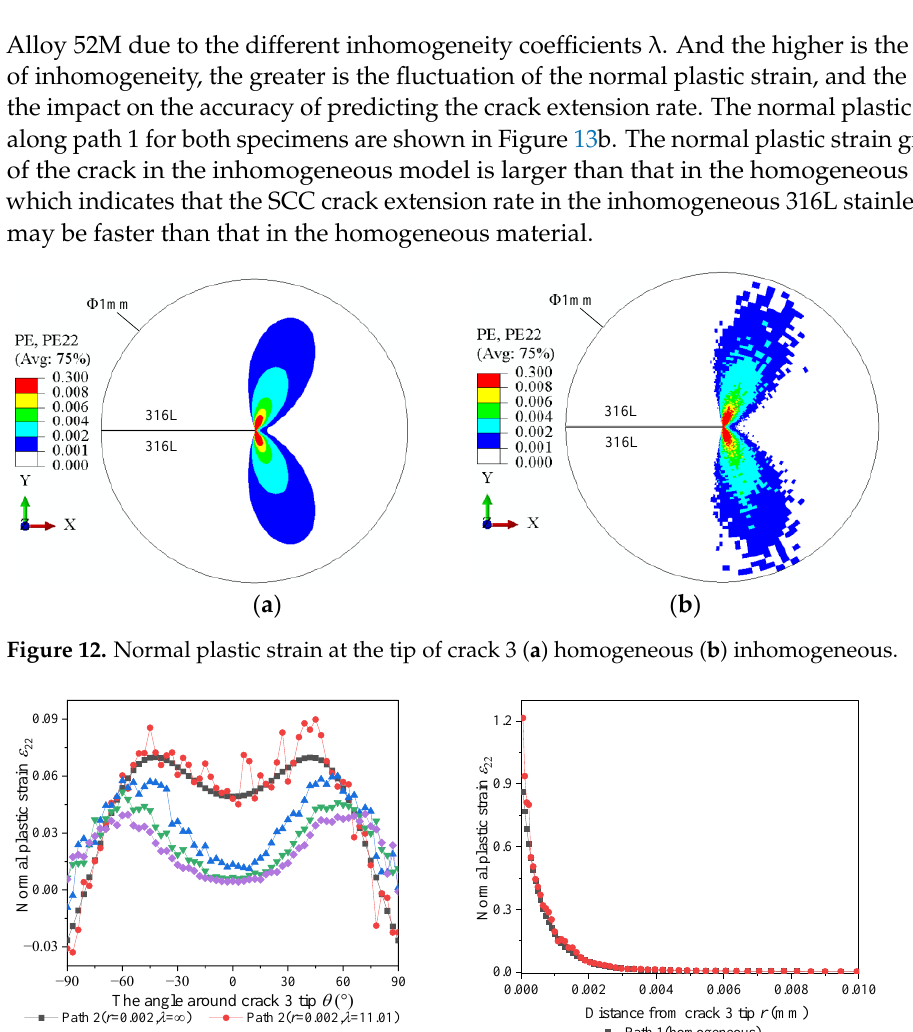
Figure 13. Normal plastic strain under homogeneous and inhomogeneous conditions: ( a ) around the crack 3 tip; ( b ) in front of the crack 3 tip.